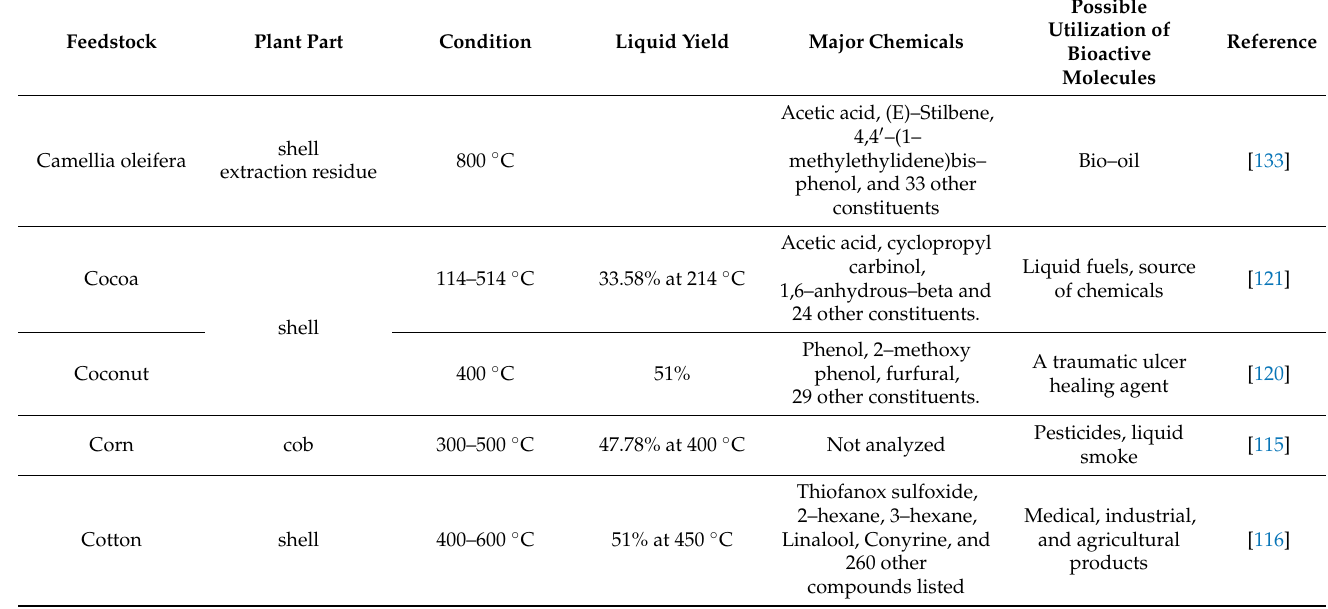
Table A3. Pyrolysis